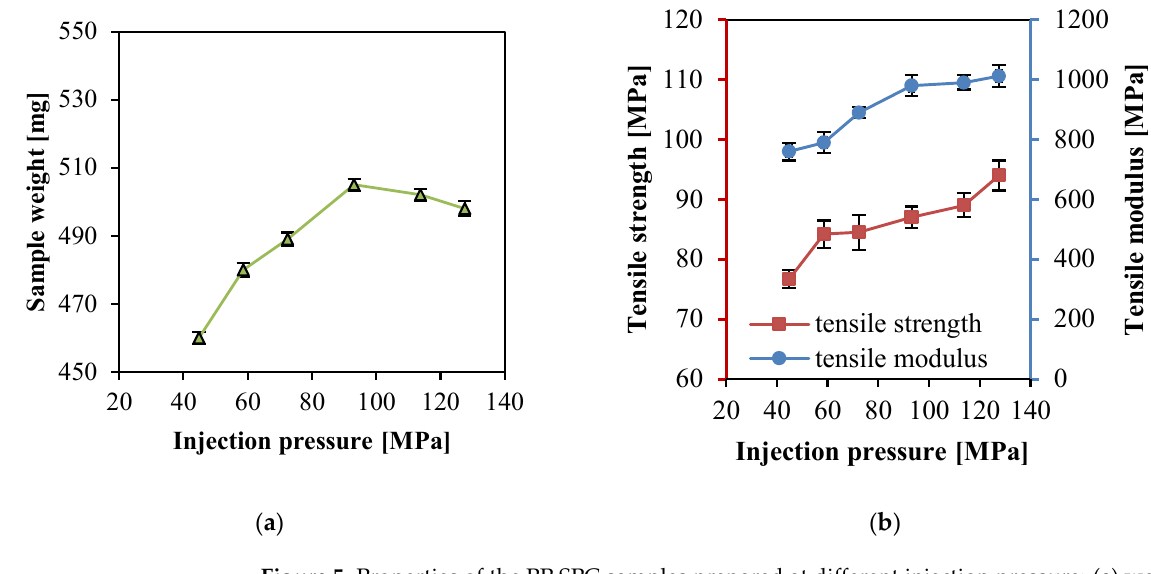
Figure 5. Properties of the PP SPC samples prepared at different injection pressure: ( a ) weight, and ( b ) tensile and tensile modulus.